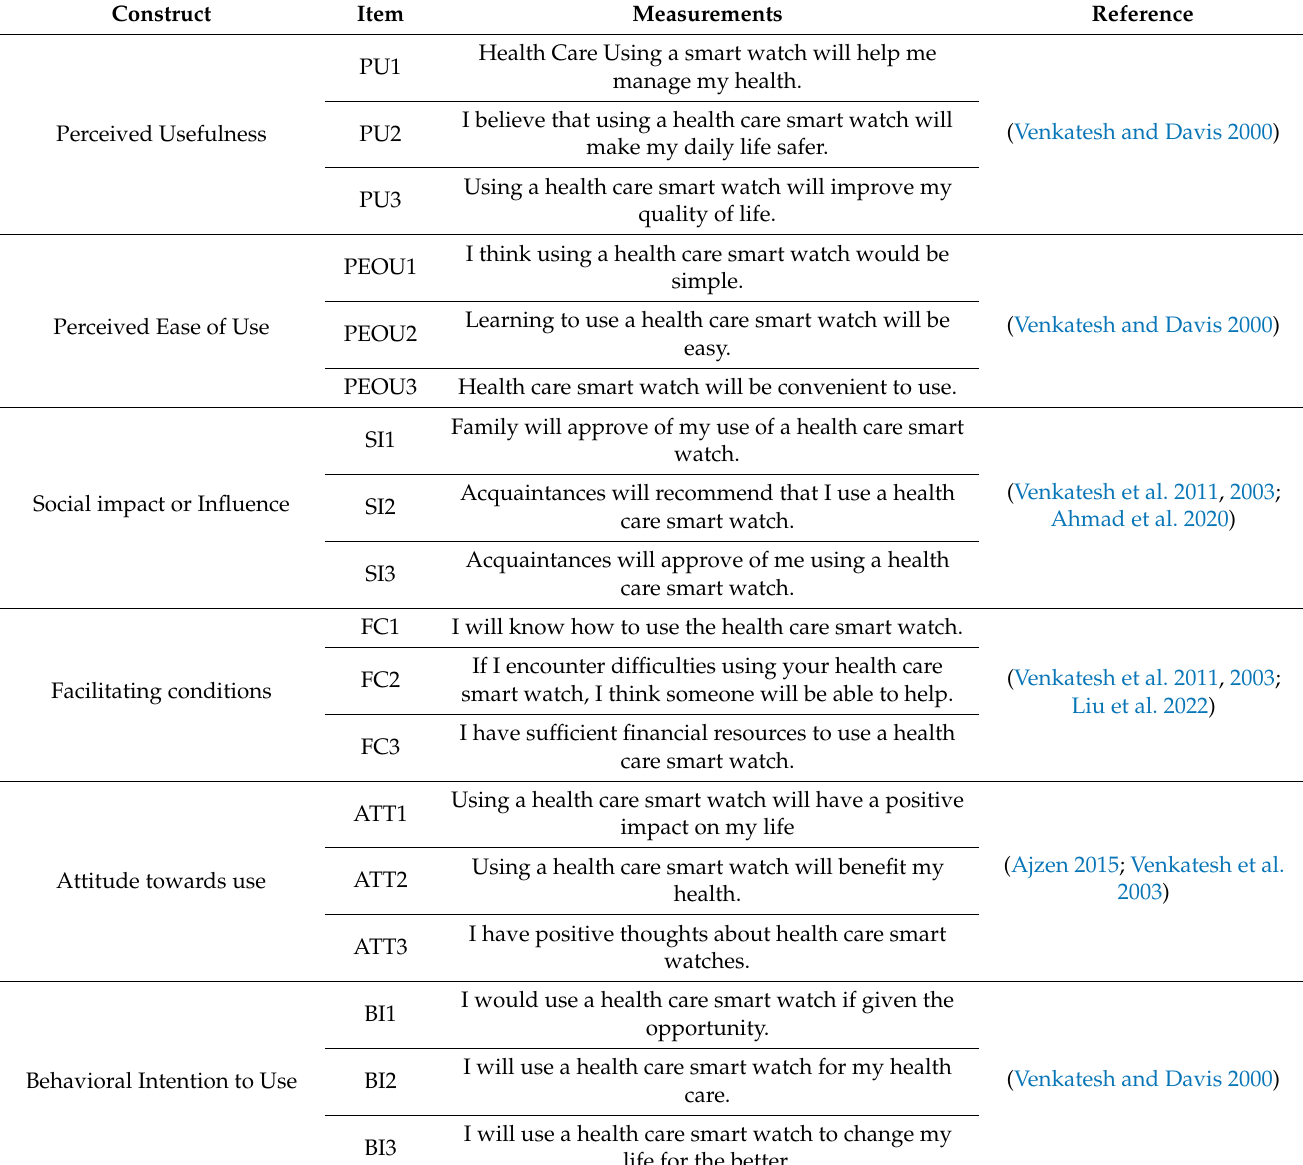
Table 1. Measurement items of